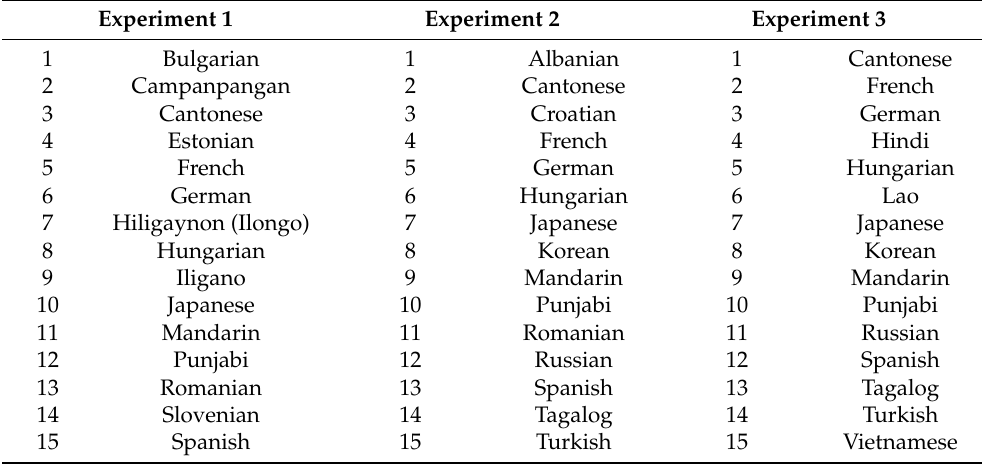
Table A1. Languages in addition to English learned by the bilingual participants in Experiment